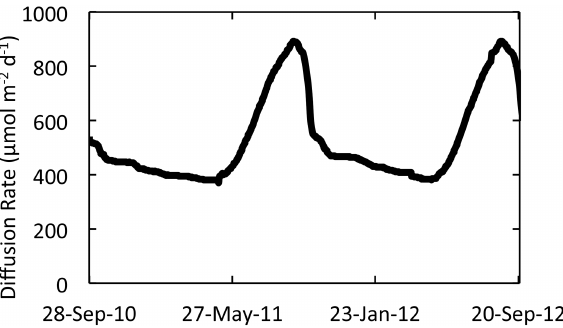
Figure B2. The rate of CH 4 diffusion from the sediments of Goldstream Lake applied in the model during the study period, calculated as described in Sect. 2.2.10. The methanogenic rate increases as the temperature of surficial sediments increases, causing the observed annual cycle in the diffusion rate.